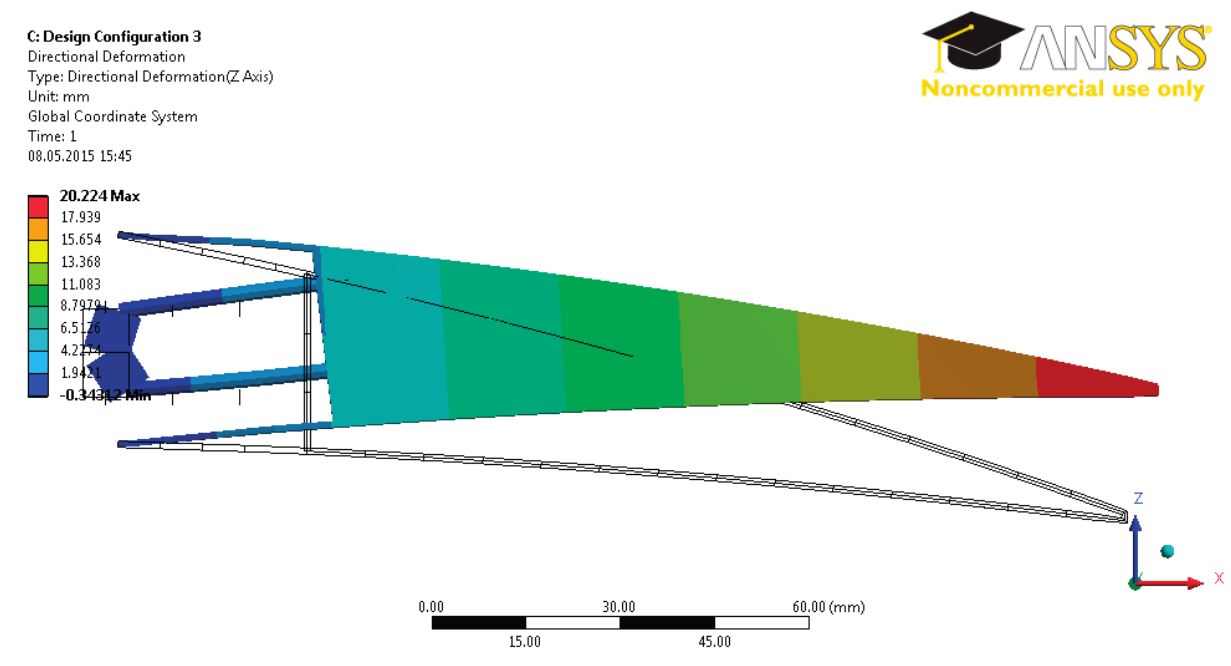
Figure 22. Deformation along Z -axis for design configuration